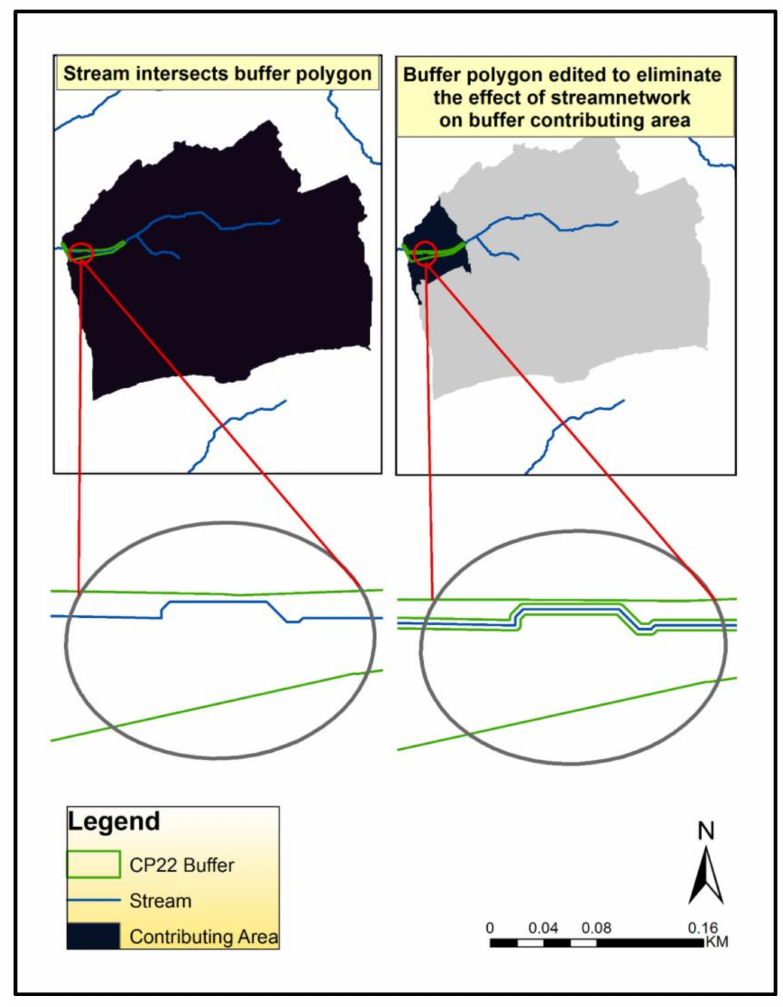
Figure 2. Contributing area restricted to the riparian forest (CP22) buffer by erasing a portion of the CP22 buffer that is intersected by the stream